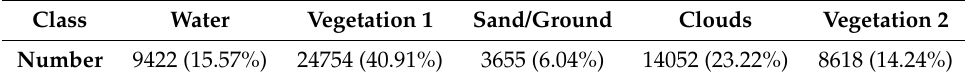
Table 5. The number of all pixels founded in each